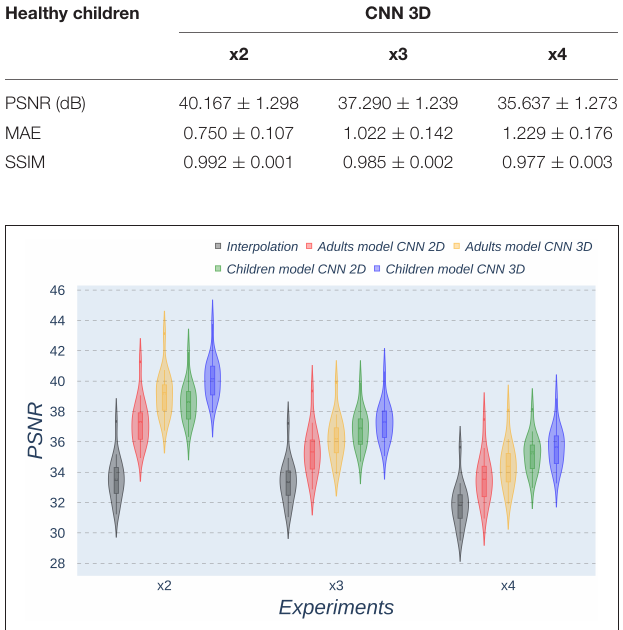
FIGURE 4 | Violin plots for PSNR metric comparing the different methods at the distinct scaling factors. Each violin plot corresponds to one specific experiment, and it is calculated from healthy subjects.